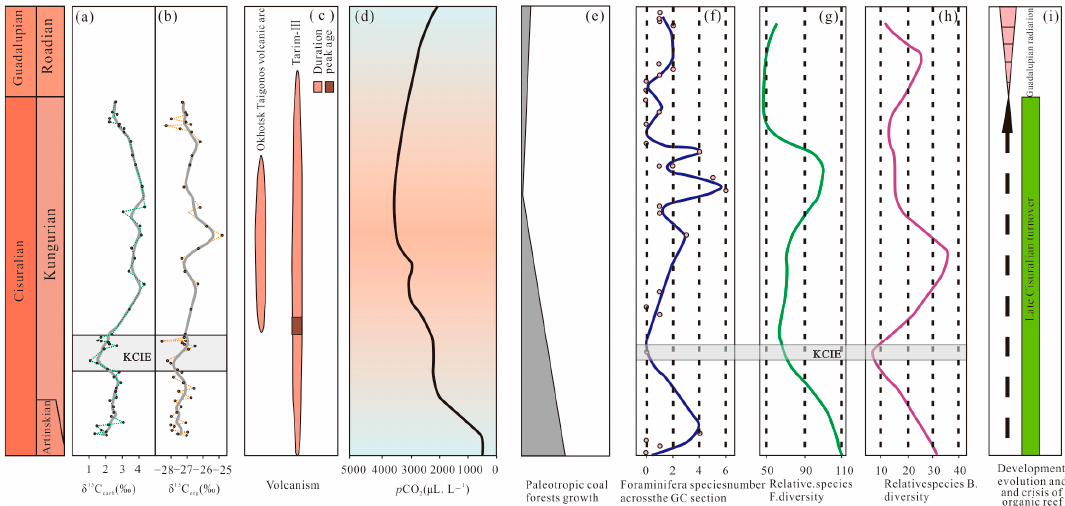
Figure 7. Correlations of organic carbon isotope and inorganic carbon isotope records and the paleoenvironmental events from the Permian-Kungurian stages. ( a ) Vertical change trends in δ 13 C carb in the study area (this study); ( b ) vertical change trends in δ 13 C org in the study area (this study); ( c ) volcanic activity from [56,57,68,69]; ( d ) carbon dioxide levels from [55]; ( e ) extent of paleotropical coal forests from [70]; ( f ) foraminifera species number across the GC section from [19]; ( g ) the relative species diversity in fusulinids of the North American shelf is taken from [65,66]; ( h ) the species diversity in brachiopods and bivalves of eastern Australia and New Zealand is adapted from [67]; ( i ) reef development, evolution, and crisis adapted from [71–73].